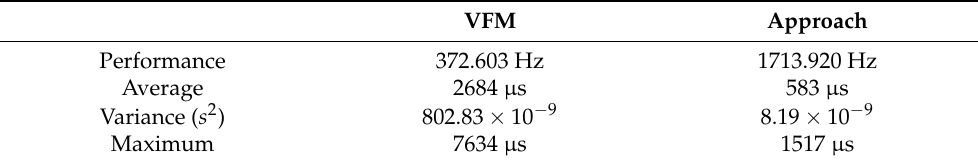
Table 6. Execution time